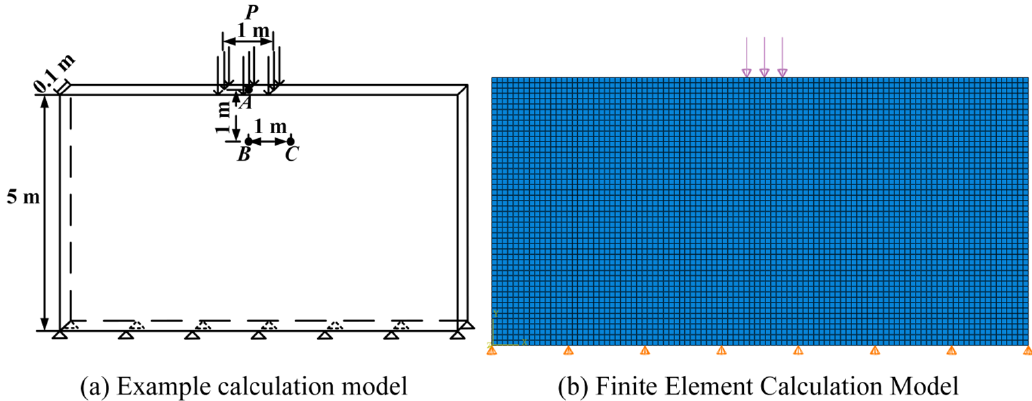
Figure 7. A schematic of the calculation example.